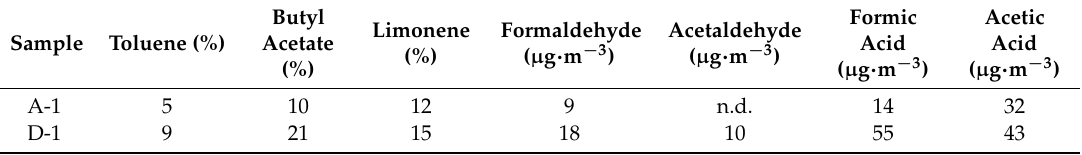
Table 4. Degradation of volatile organic compounds (VOC) in a 1 m 3 emission test chamber at 40% relative humidity under UV